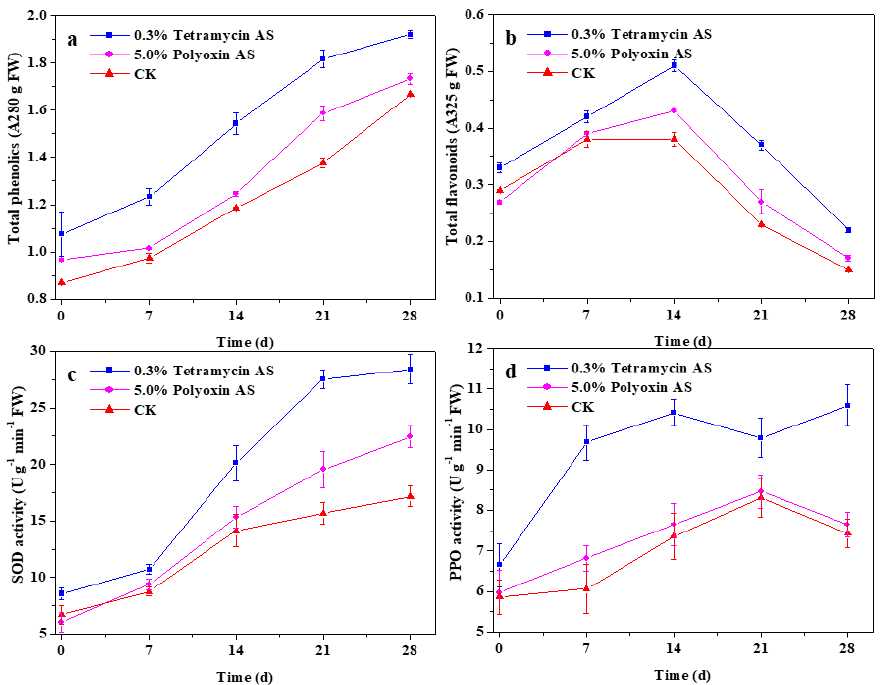
Figure 2. The effects of tetramycin and polyoxin on the changes of total phenolics ( a ) and total flavonoids ( b ), SOD activity ( c ) and PPO activity ( d ) in kiwifruit during storage. Values indicate the mean of three replicates, error bars indicate SD of three replicates.